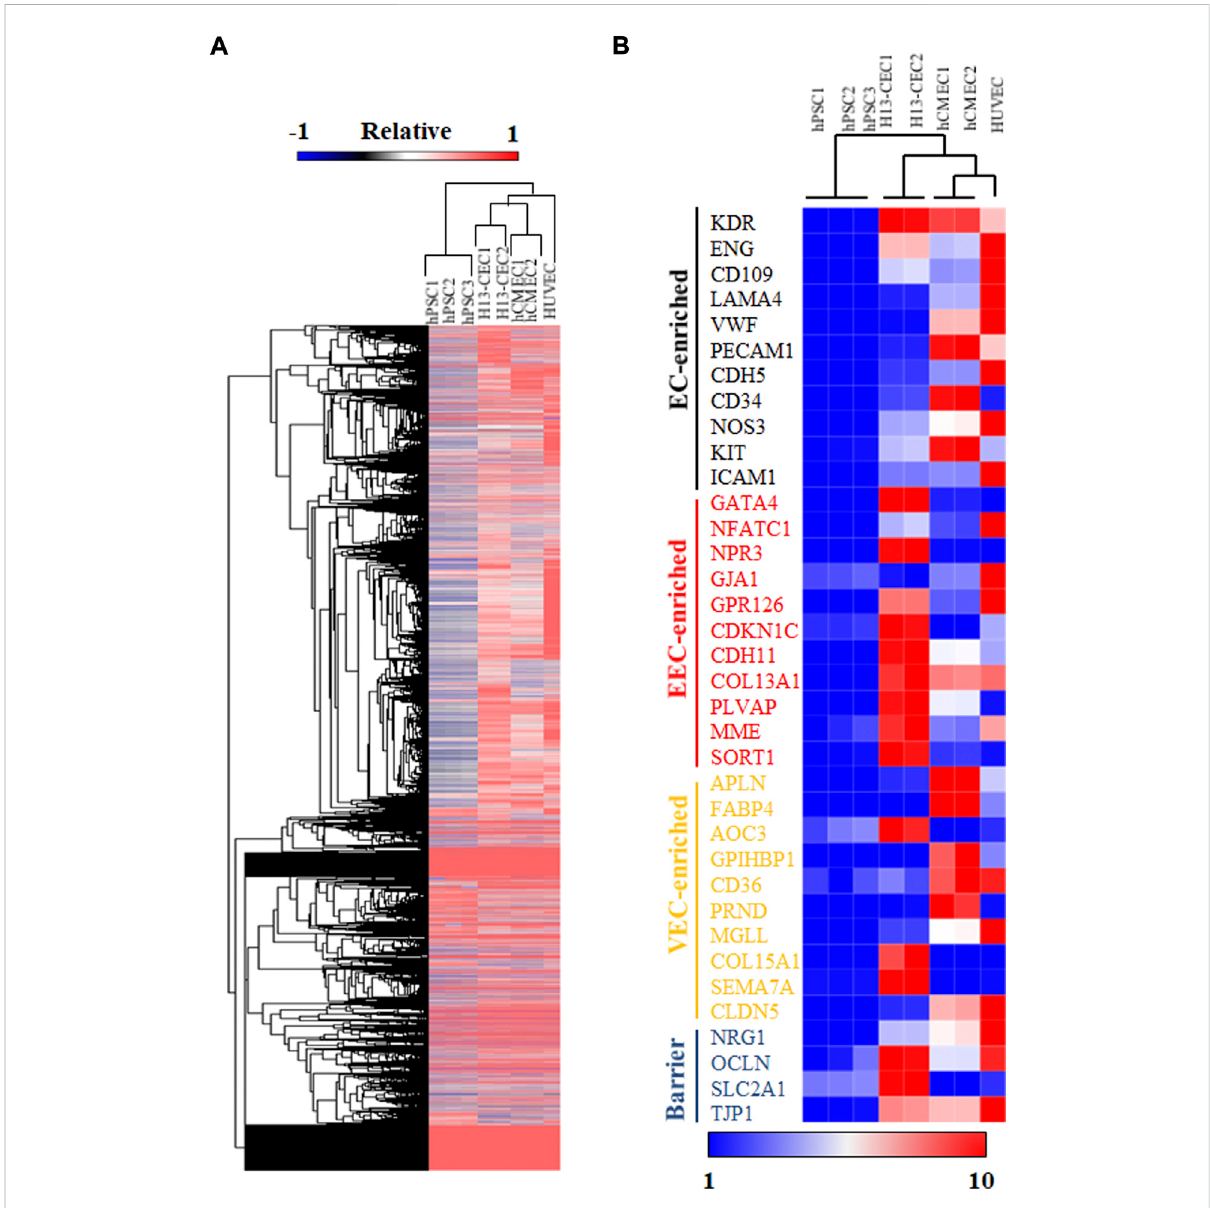
FIGURE 2 RNAsequencing(RNA-seq) analysiswasperformedonhPSC-differentiated cardiac endothelial cells(CECs). (A) Hierarchical clustering ofRNA- seq expression data of hPSCs, H13-derived cardiac endothelial cells (CEC), primary human cardiac microvascular endothelial cells (hCMEC), and human umbilical vein endothelial cells (HUVEC). (B) Heatmap and hierarchical clustering analysis of selected endothelial cell